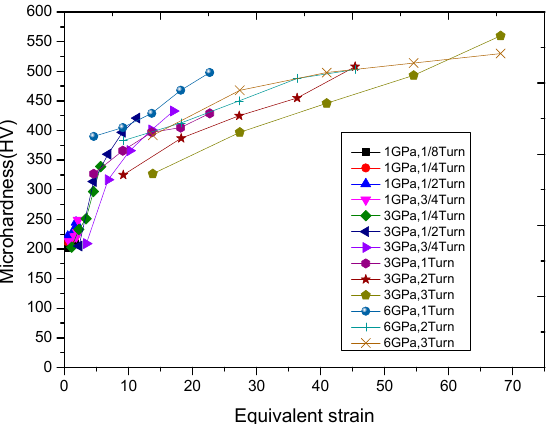
Figure 9. Values of the hardness plotted as a function of the equivalent strain under 1, 3 and 6 GPa for different numbers of turns.